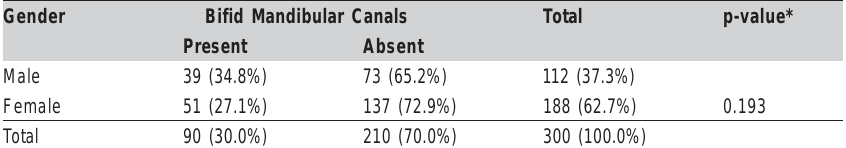
Table 2 - Absolute (n) and relative (%) frequencies of bifid mandibular canals in CBCT images according to gender